Question: Write a descriptive caption for this figure.
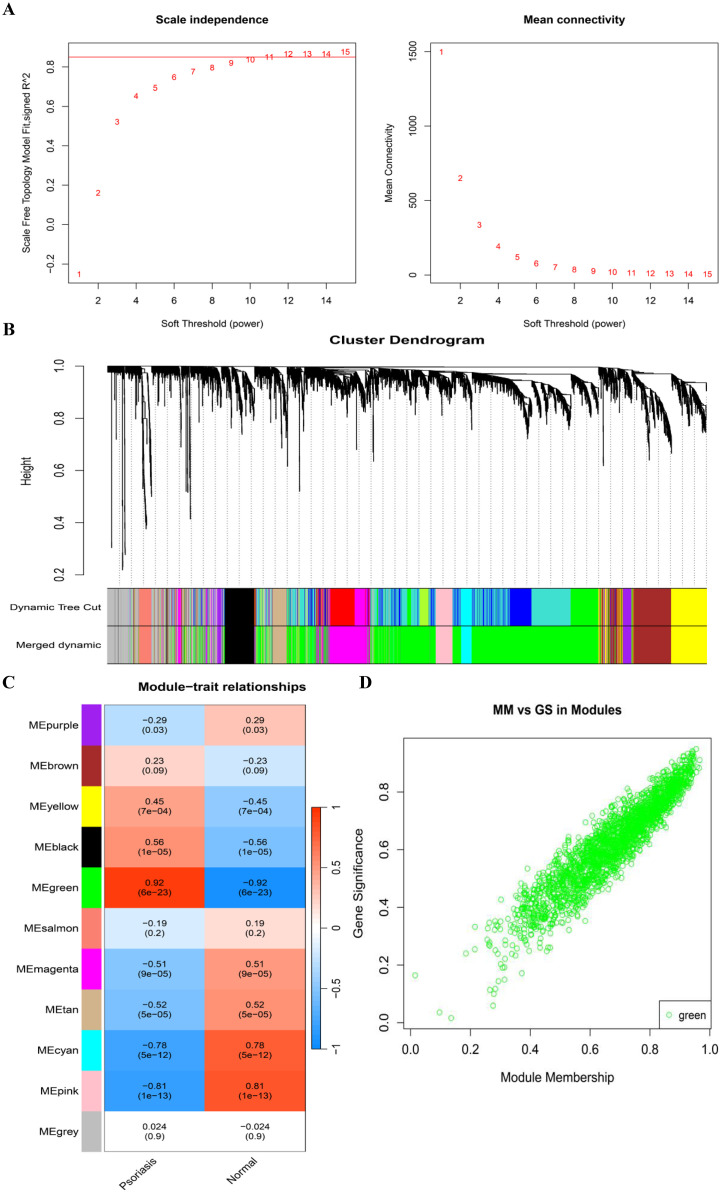
Answer: WGCNA identifies a psoriasis-associated co-expression module. (A) Scale-free topology analysis for soft-threshold selection. (B) Hierarchical clustering dendrogram with module assignment. (C) Heatmap of module–trait relationships. (D) Scatter plot showing the relationship between module membership and gene significance in the disease-associated module.